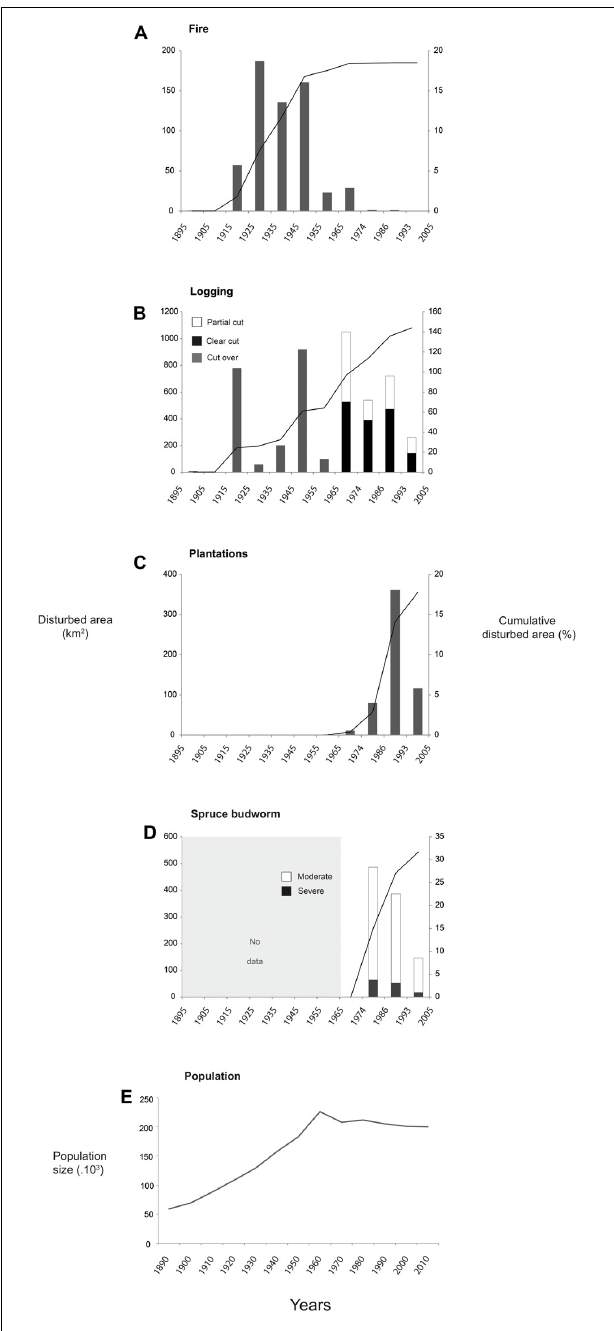
FIGURE 4 | Disturbed area (bars) and cumulative disturbed area (lines) per decade for: (A) Fire, (B) Logging, (C) Plantations, and (D) Spruce budworm outbreaks. Logging type is divided into partial and clear cuts between 1975 and 2005. Areas of spruce budworm outbreaks are divided into moderate and severe outbreaks. (E) Trend in human population in the LSL administrative region (Census Canada in Fortin et al., 1993).